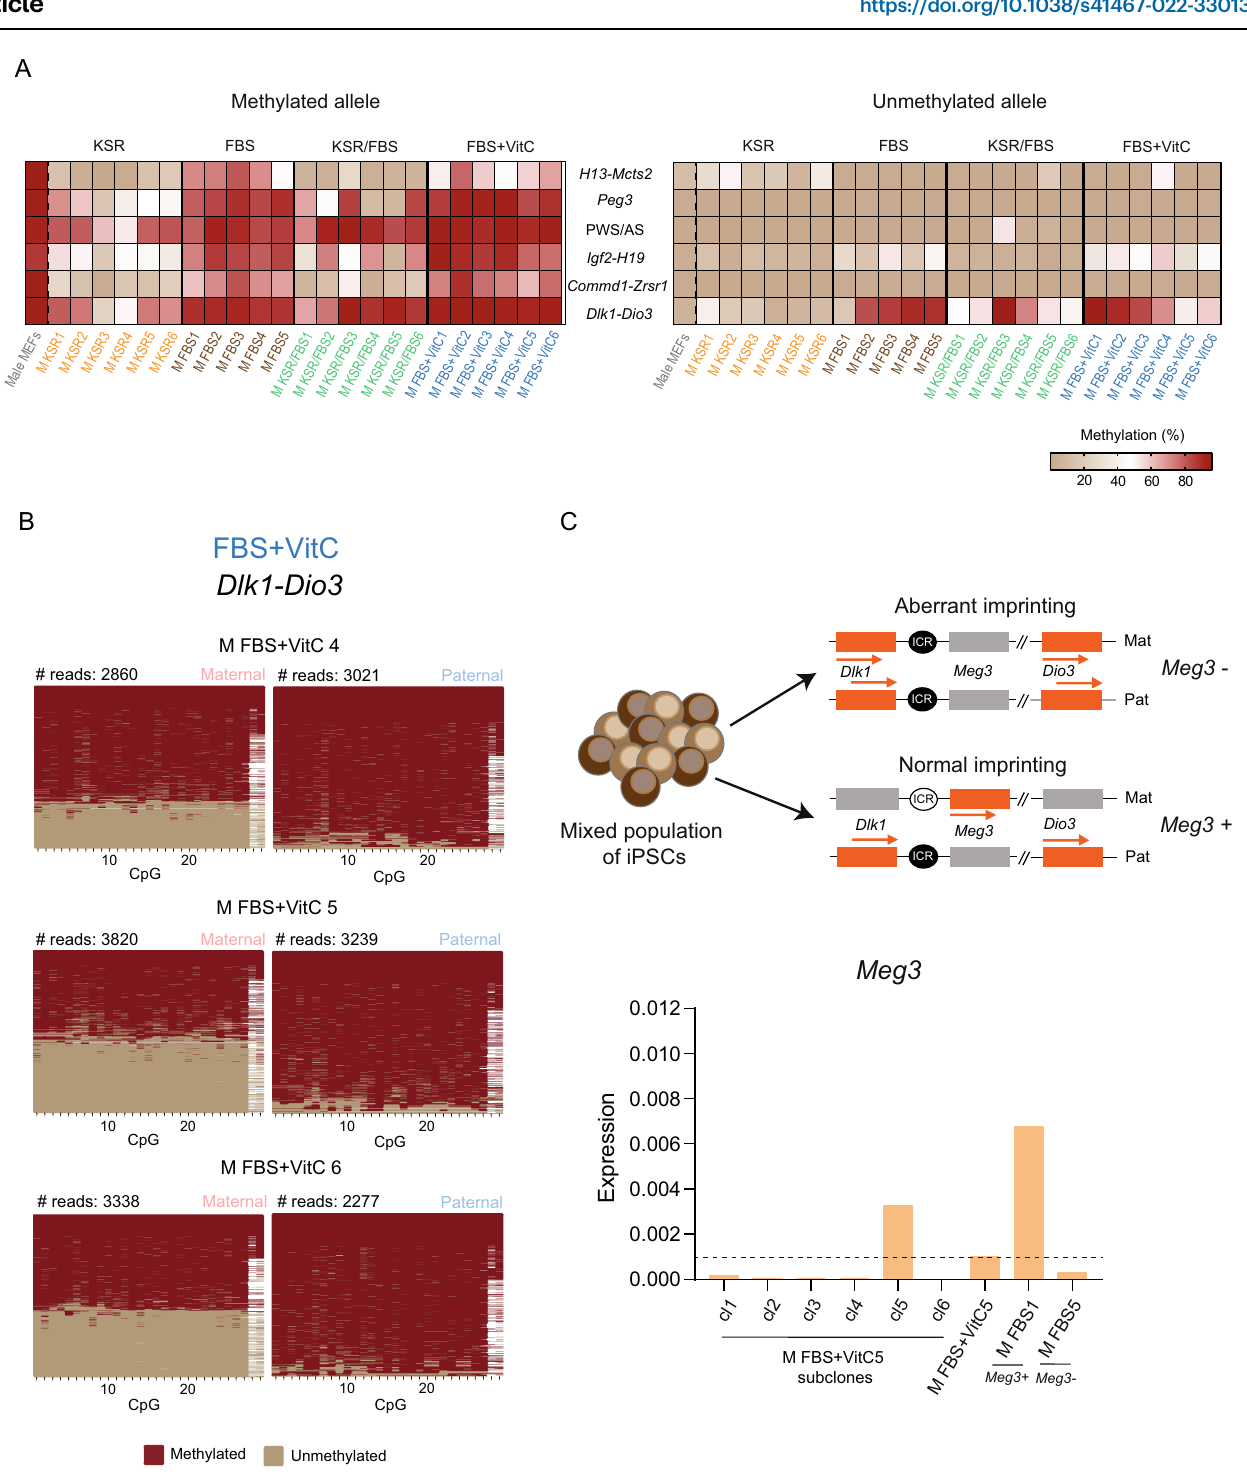
results in Fig. 7B. The status of Dlk1-Dio3 ICR with normal and abnormal (hyper- methylation) imprinting are also displayed (white circle – unmethylatedICR; black circle – methylated ICR; Mat – maternal allele; Pat – paternal allele; orange rec- tangles – expressedgenes;greyrectangles – silenced genes;regionsarenotdrawn to scale). On the bottom, graph represents the RT-qPCR expression analysis of Meg3 expression normalised with the Gapdh housekeeping gene in the subclones of MFBS+VitC5,originalM FBS+VitC5 and M FBS1 (normal imprinting)and M FBS5 (hypermethylatedphenotype);dashedlinerepresentsthe Meg3 expressionlevelof the parental M FBS+VitC5 iPSC line; each bar represents data from only one bio- logical replicate. Source data are provided as a Source Data fi